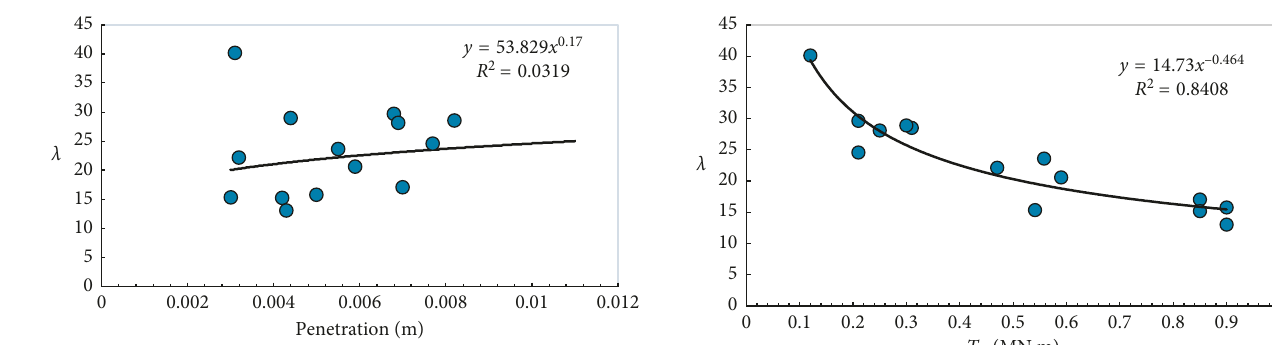
Figure 1: Relationship between λ and penetration.